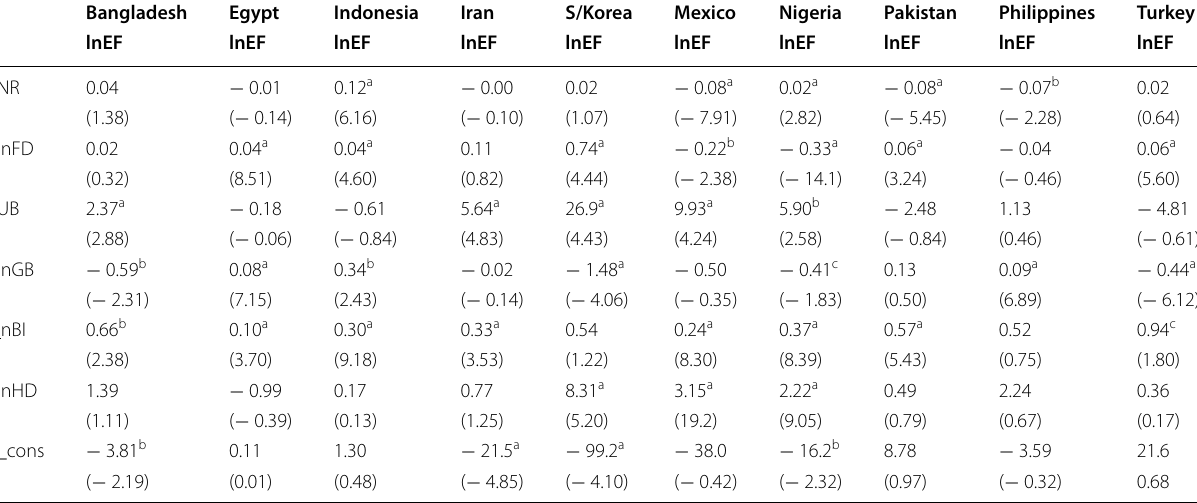
Table 8 Model 1 with lnEF as the dependent